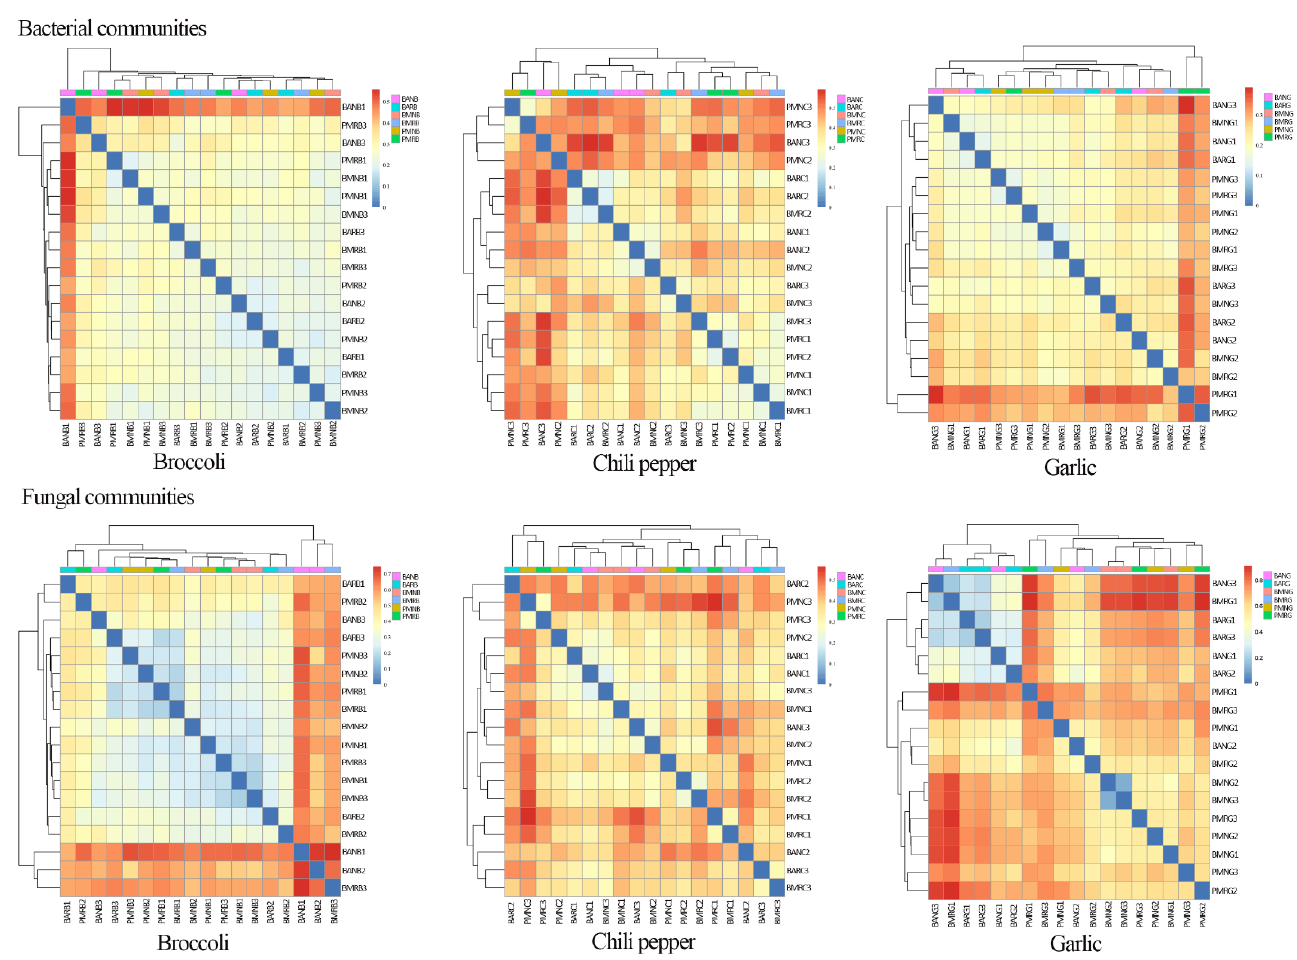
Figure 4. Bray–Curtis distance analysis in three different vegetable fields under different Figure 4. Bray – Curtis distance analysis in three different vegetable fields under different treat- ments.